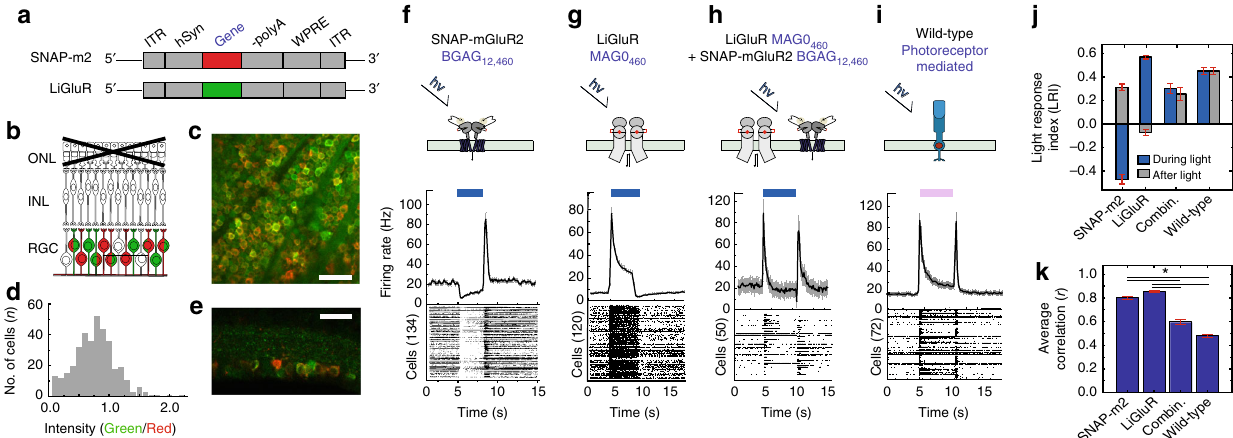
Fig. 4 Light responses when combining LiGluR and SNAG-mGluR2 in RGCs. a Viral DNA expression cassette. SNAP-mGluR2 (red) and LiGluR (green). b – e RGCs expressing LiGluR (green) and SNAP-mGluR2 (red). b Schematic of degenerated rd1 mouse retina. c , e Confocal images of rd1 mouse retina 4 weeks after intravitreal injection of 1:1 mixture of AAV2/2-hSyn-LiGluR and AV2/2-hSyn-SNAP-mGluR2 (5 × 10 11 viral genomes). LiGluR stained with anti-iGluR6 (green); SNAP-mGluR2 with BG-Alexa Fluor 647 (red). d Histogram displaying the distribution of anti-iGluR6 (green)/SNAP-mGluR2 (red) intensity ratios for each cell n = 354, N = 3. f – i Schematic (top) and RGC MEA response to 5 s pulse of 472 nm light (bottom) in rd1 retina whose RGCs contain either SNAP-mGluR2 + BGAG 12,460 ( f ), LiGluR + MAG0 460 ( g ), or both SNAP-mGluR2 and LiGluR + photoswitchs ( h ). Photoreceptor-mediated response in wt shown for comparison ( i ). Raster plots of individual units are averages of 5 fl ashes, SEM in gray. j LRI of peak responses during (blue) and after (gray) illumination in rd1 retinae with SNAG-mGluR2, LiGluR, SNAP-mGluR2 and LiGluR together (Combin.), and in wt retina. Values mean ± SEM n ≥ 50, N = 4. k Average cross-correlation values in rd1 retinas with SNAG-mGluR2 ( n = 134), LiGluR ( n = 120), SNAG-mGluR2 + LiGluR ( n = 90), and in wild-type retina ( n = 93). Cross-correlation of all light-sensitive units in period 1 s before to 2 s after light pulse. Values mean ± SEM. Light 472 nm at 50 mWcm − 2 . Photoswitch concentration 50 μ M. N = # of retina, n = # of units/cells, all units refer to sorted cells. Statistical signi fi cance was assessed using